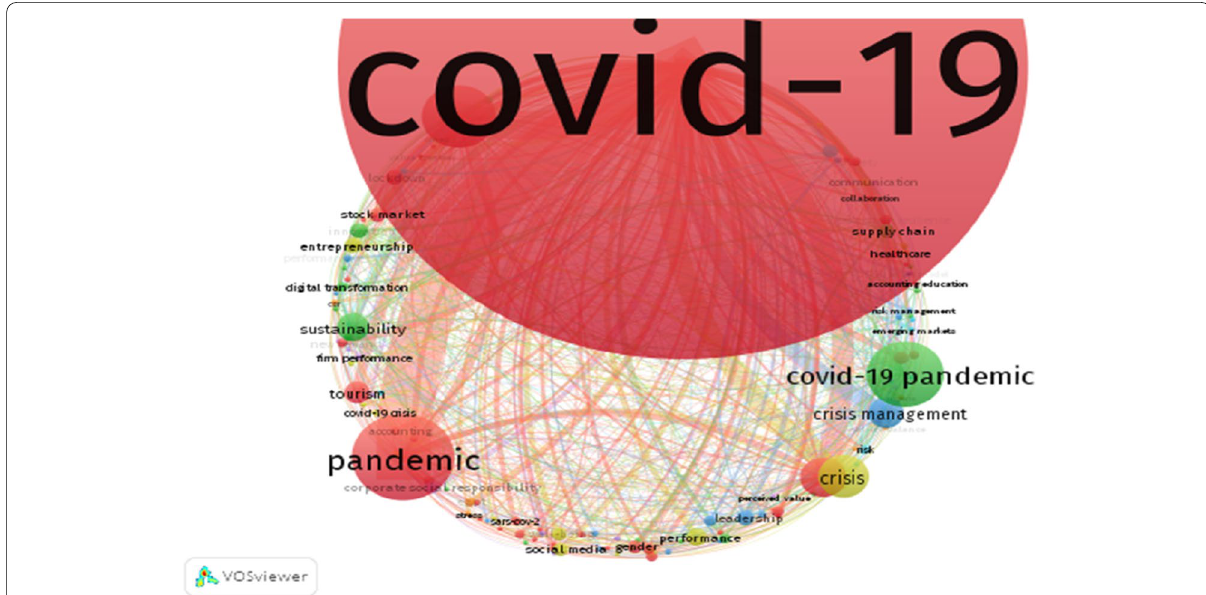
Fig. 2 Network visualization diagram of authors keyword on Covid‑19 and